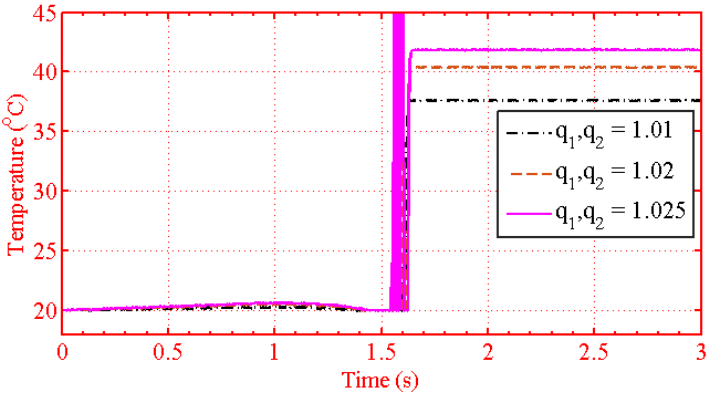
Figure 21. The output temperature in cold fluid as q 1 , q 2 > 1.